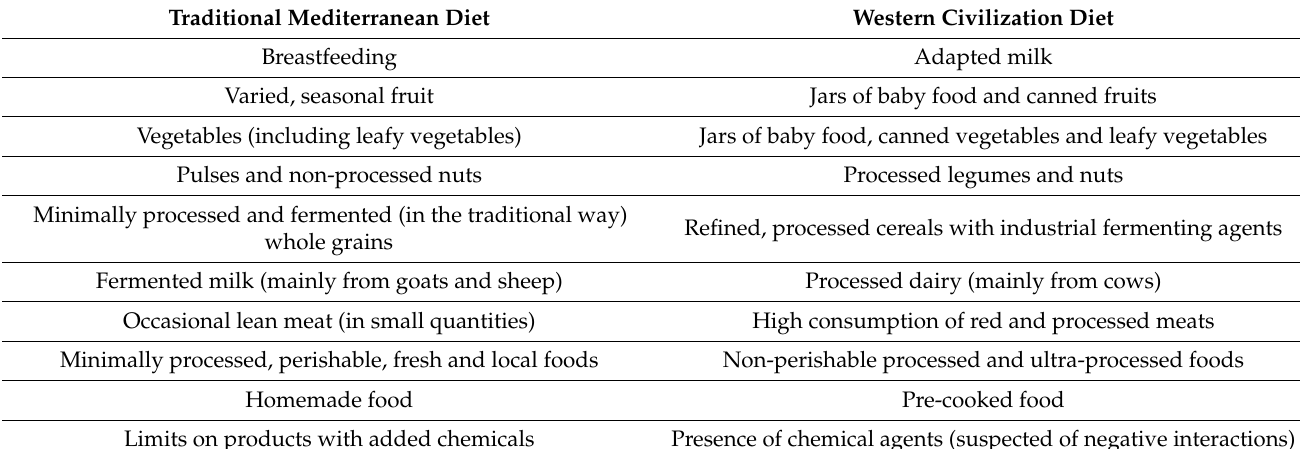
Table 3. Differences between the Traditional Mediterranean Diet and the “Western civilization”